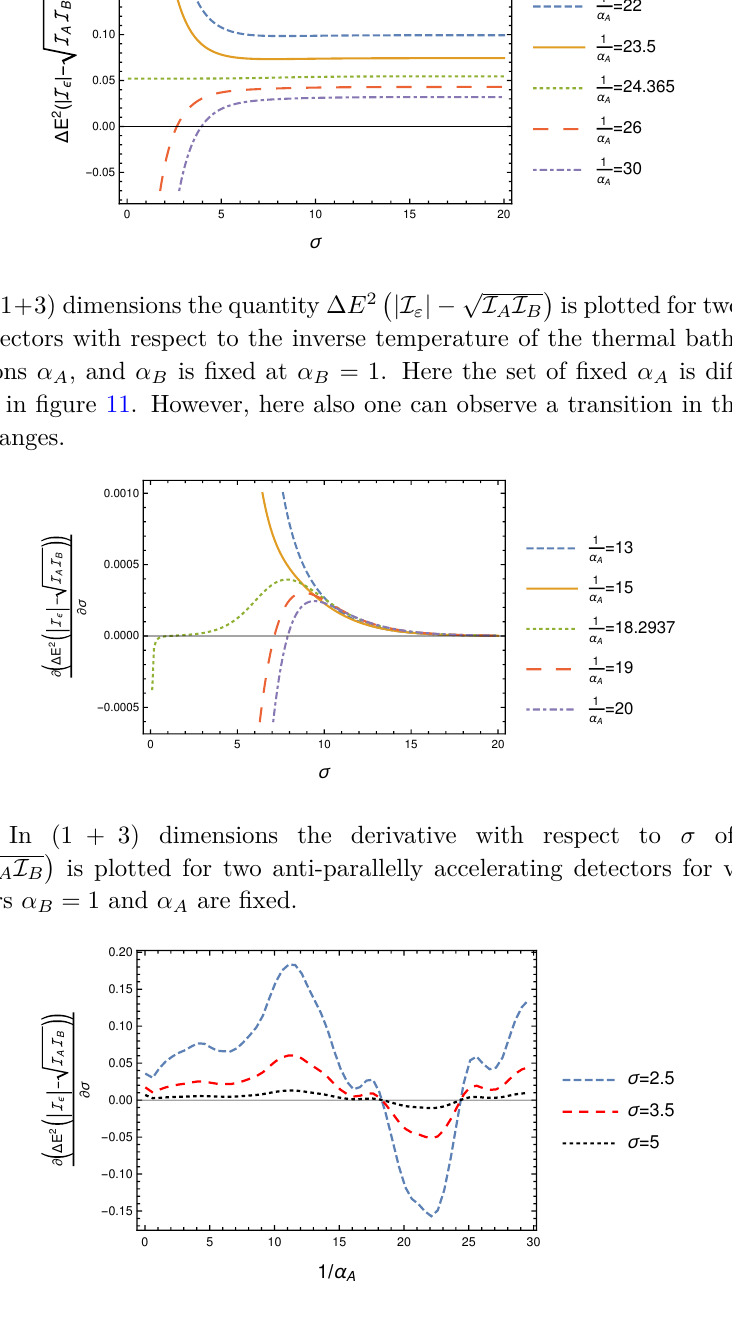
Figure 14 . In (1 + 3) dimensions the derivative with respect to σ of the quantity √ (cid:1) is plotted for two anti-parallelly accelerating detectors for varying acceler- ∆ E 2 (cid:0) |I I A I B ε | − ation of the first detector α . The temperatures of the thermal bath σ and other parameter A α B = 1 are